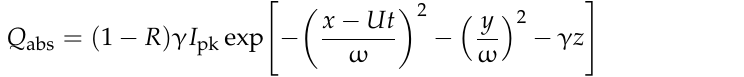
Figure 9. ( a ) Bending test apparatus; ( b ) resistance drift.